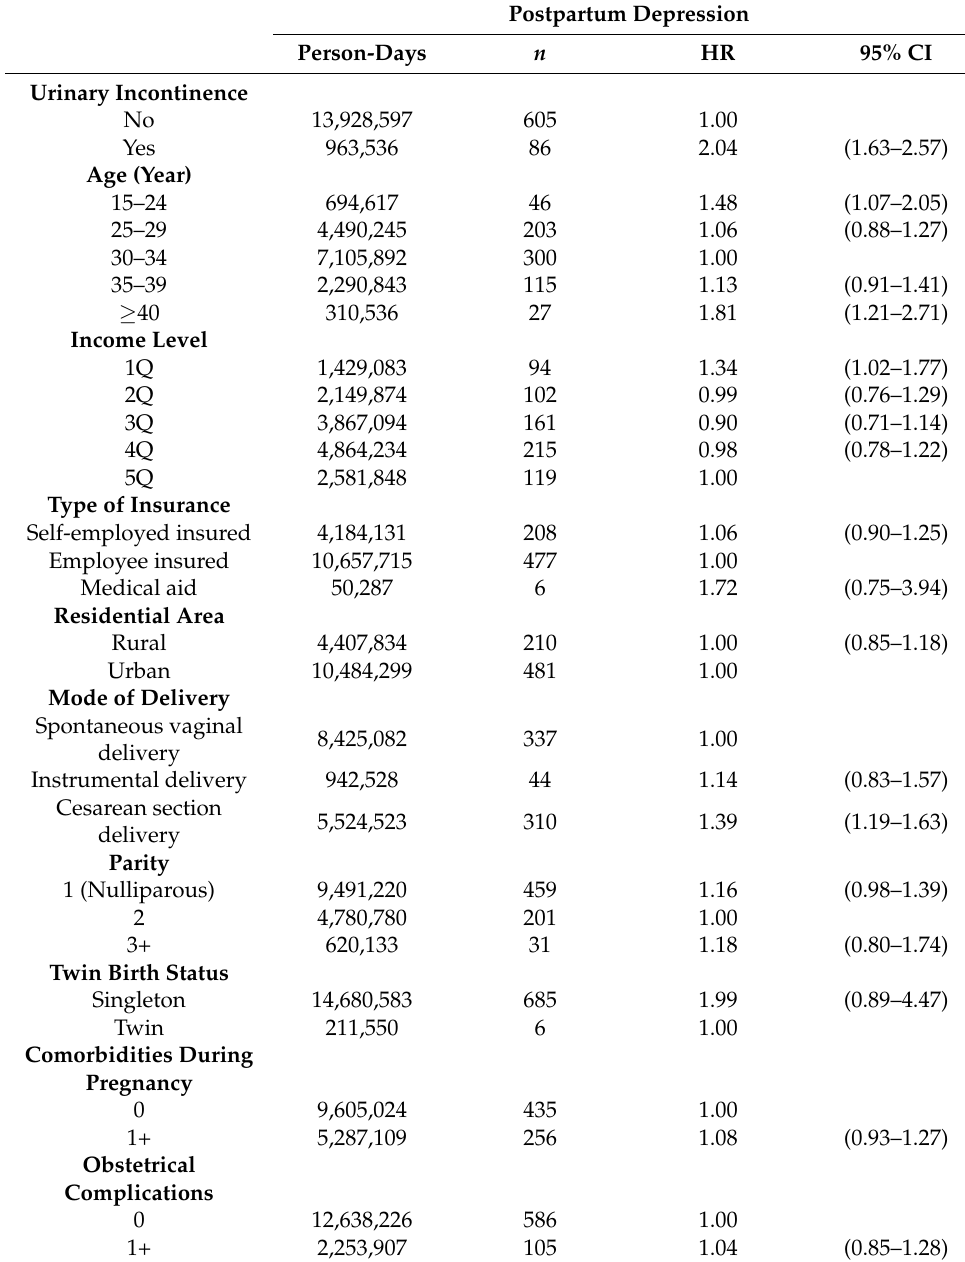
Table 2. Cox proportional hazard ratios for postpartum depression within six